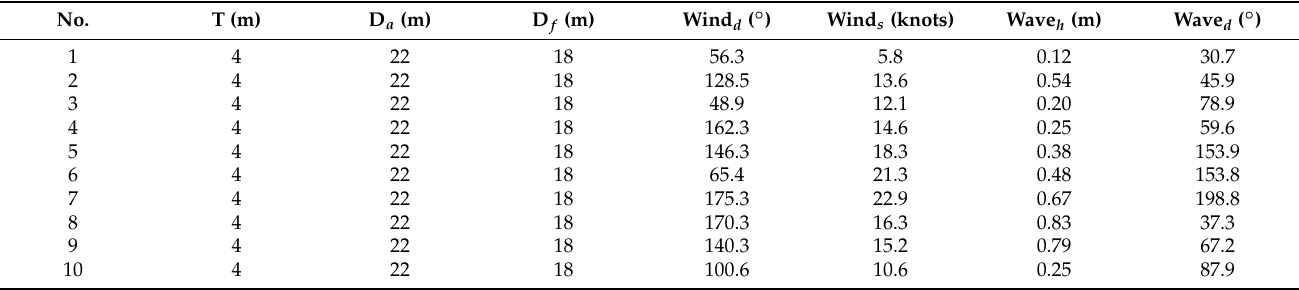
Table 6. Ten simulated